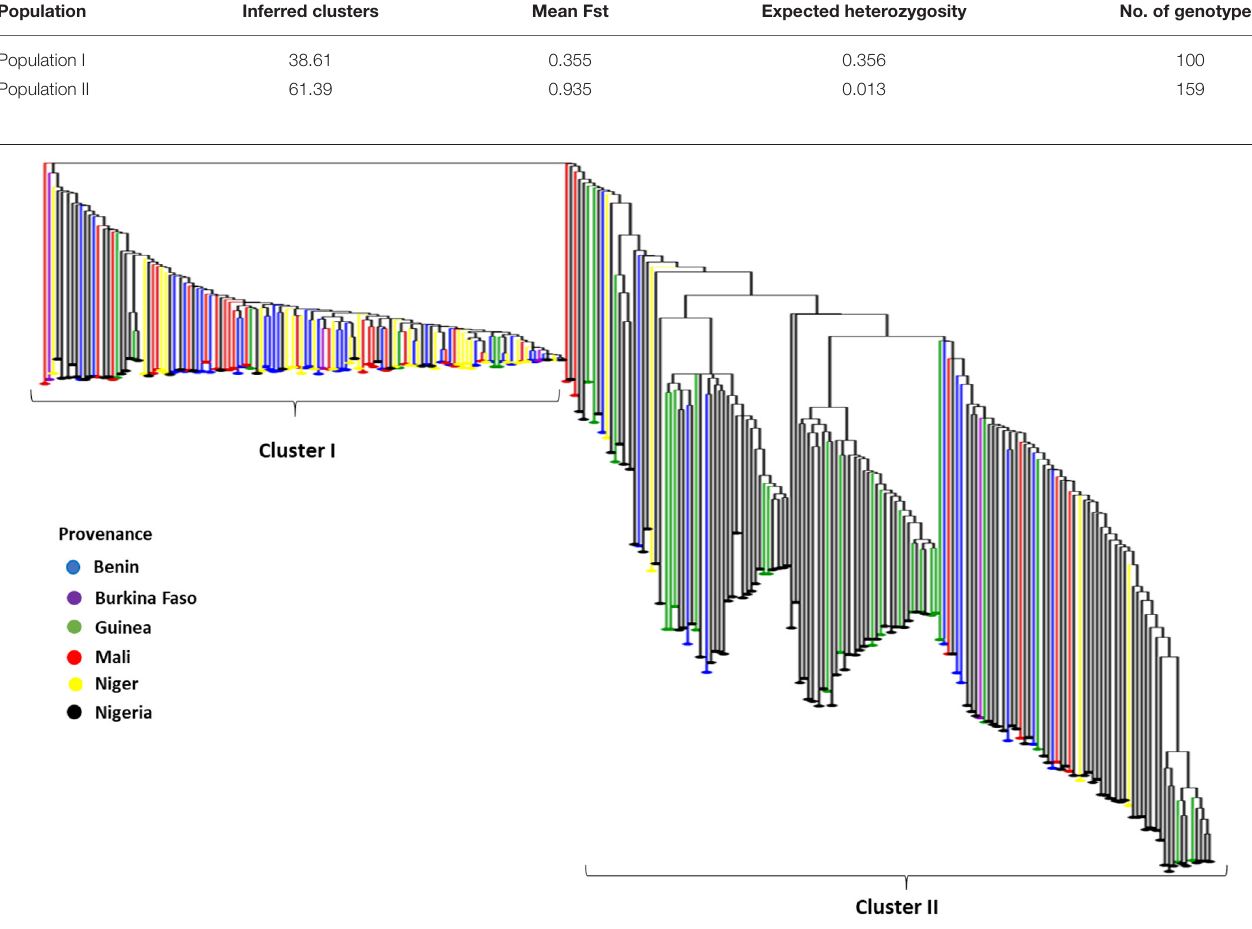
FIGURE 4 | The Neighbor-Joining dendrogram based on dissimilarity among 259 fonio accessions using 688 SNP markers. NB: Depending on the provenance accessions were colored as follows: Benin = blue, Burkina Faso = purple, Guinea = green, Mali = red, Niger = yellow and Nigeria = black.